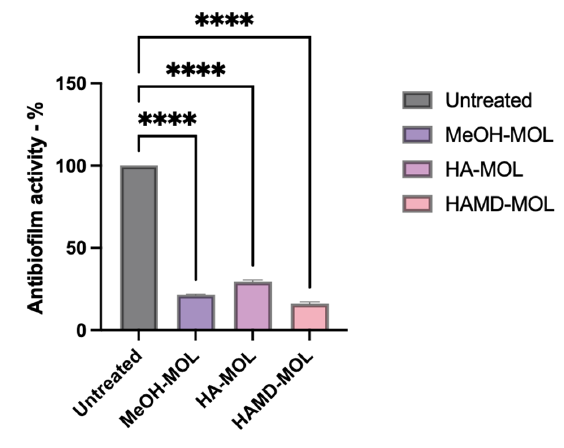
Figure 3. In vitro biofilm formation assay. X. campestris pv. campestris biofilm was measured by OD 600 , presented as a percentage compared to untreated control. Data represent the average of three independent experiments on three copies (mean ± standard deviation), and values are given as percentages; **** p < 0.001. The analysis performed on the activity of single strains can be found in Supplementary Figure S3 and Table S4.